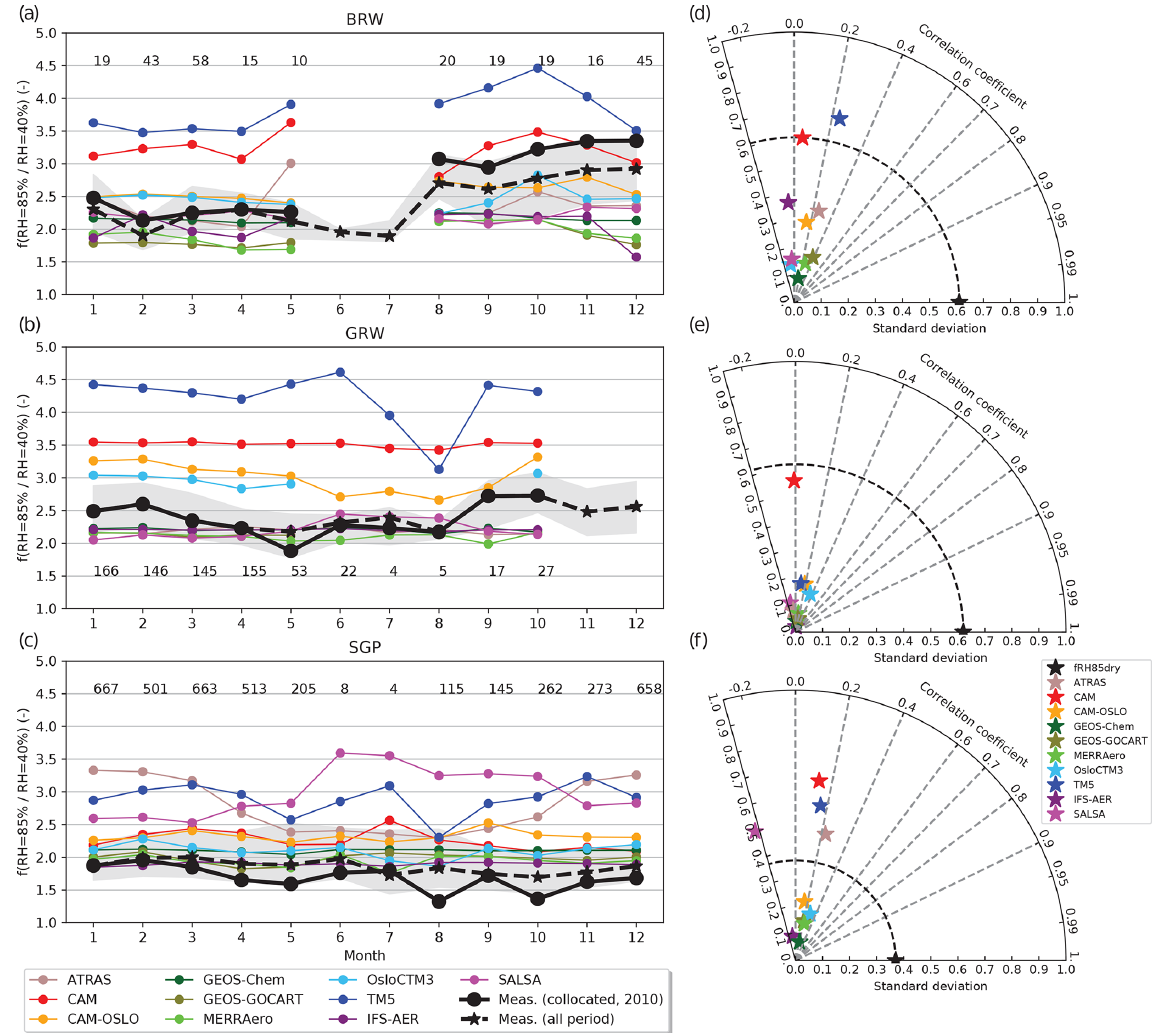
Figure 4. Comparison of f (RH = 85% / RH ref = 40%) at λ = 550nm for 2010: Barrow (Arctic site), Graciosa (marine site), and Southern Great Plains (rural site). (a–c) Annual cycles of the median f (RH = 85% / RH ref = 40%) as measured (black line) and as predicted by the models (colored lines) co-located for 2010. The black dashed line and gray underlying area represent the median and range for the entire dataset. The numbers of data points in each month are also indicated. (d–f) Taylor diagrams showing the correlation coefficients and standard deviations of f (RH = 85% / RH ref = 40%) for measurements (black symbols) and models (colored symbols; see